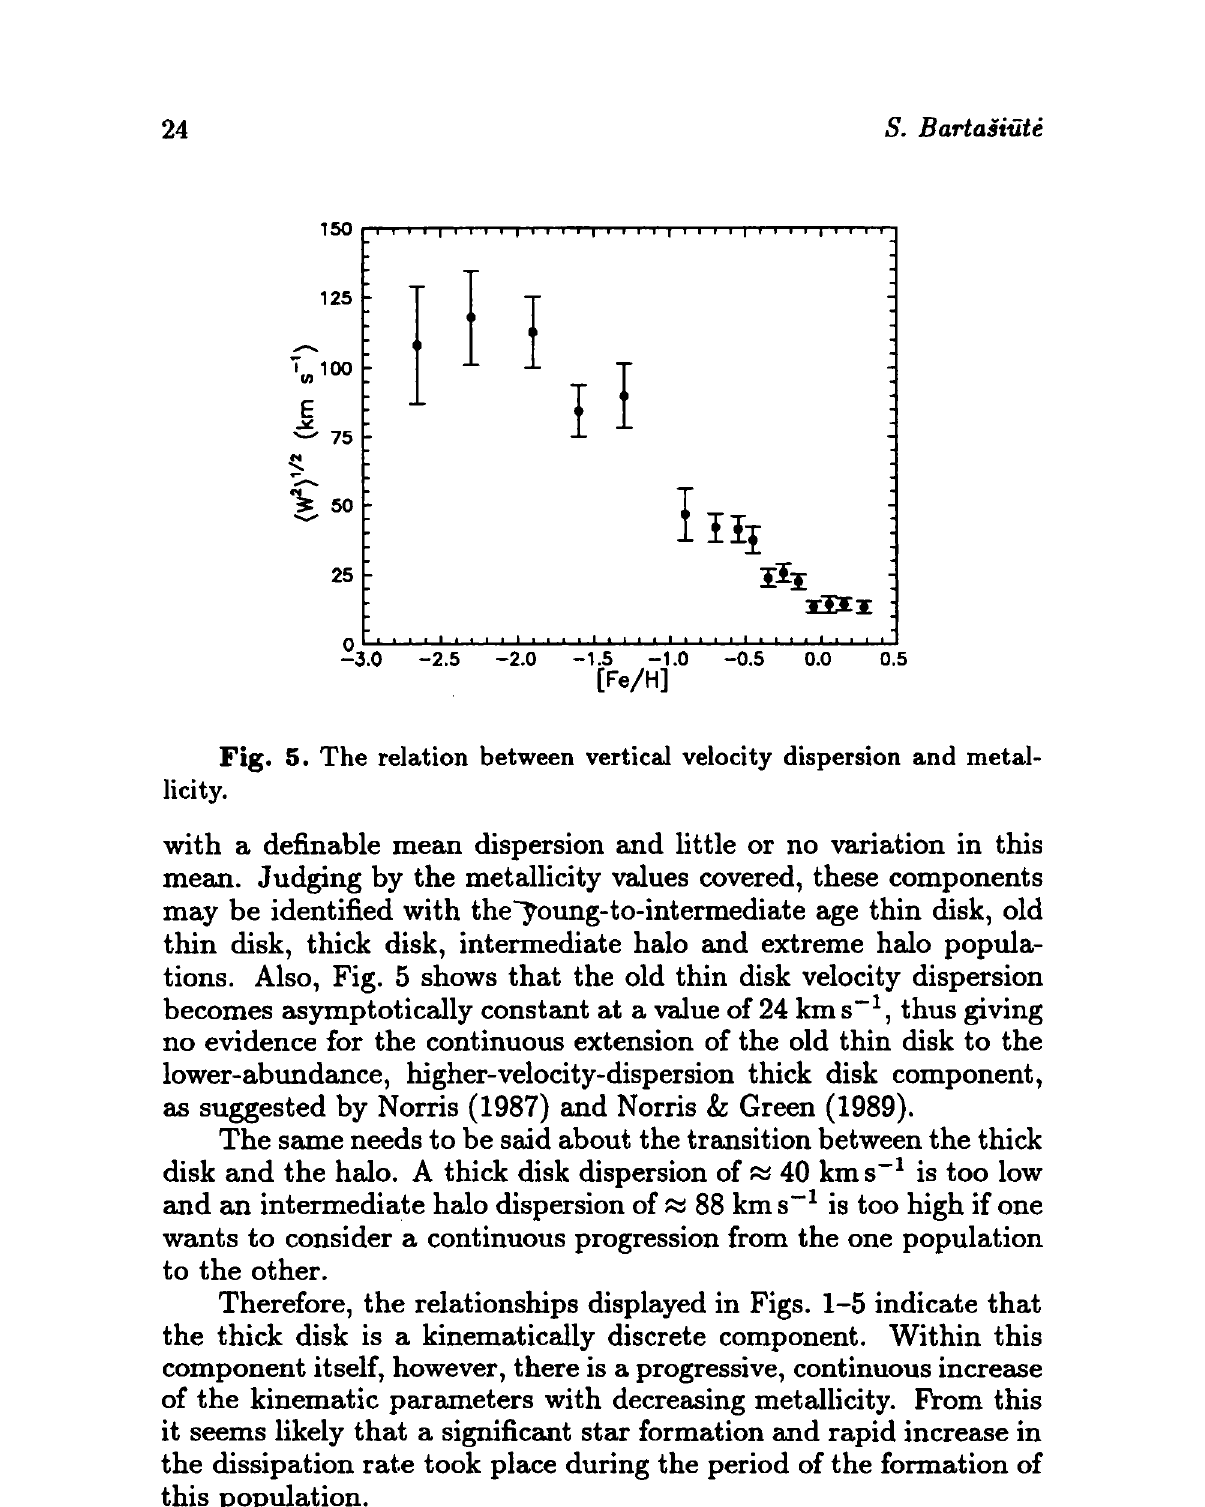
Fig. 5. The relation between vertical velocity dispersion and metal-